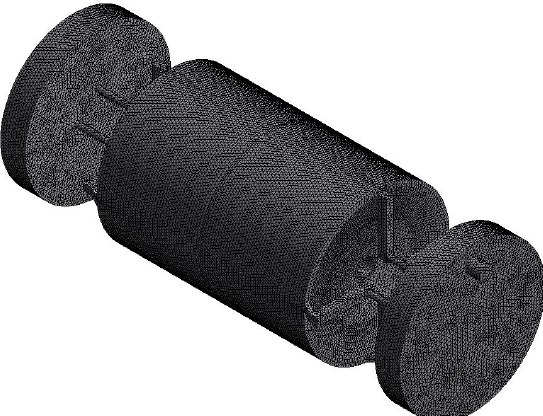
Figure 5. Mesh for the computational domain.